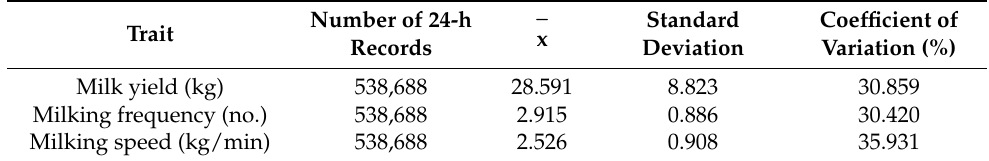
Table 1. Descriptive statistics of primiparous cows-milked in automated milking systems traits. Number of 24-h Standard Coefficient of ¯ Trait x Records Deviation Variation (%) Milk yield (kg) 538,688 28.591 8.823 30.859 Milking frequency (no.) 538,688 2.915 0.886 30.420 Milking speed (kg/min) 538,688 2.526 0.908